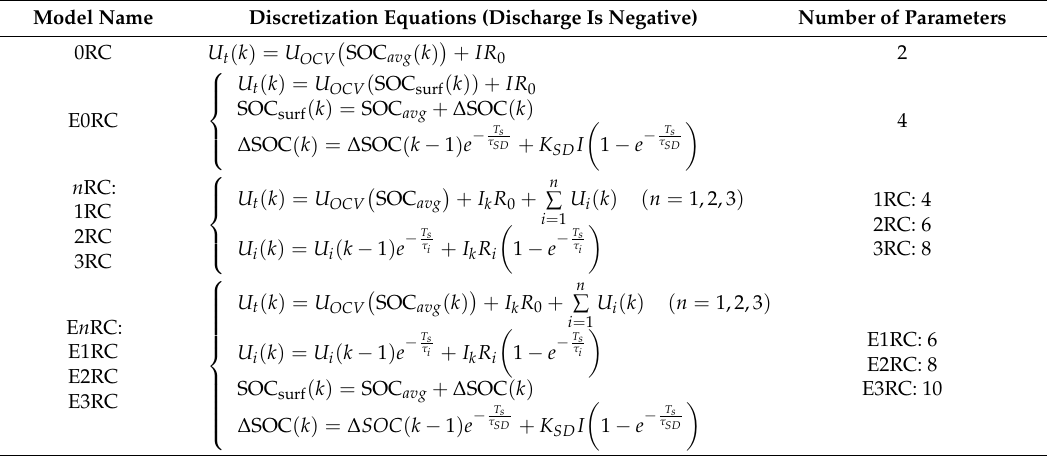
Figure 2. Schematic of the proposed E n RC model. Table 1. Discretization equations of various resistance-capacitance (RC) models.